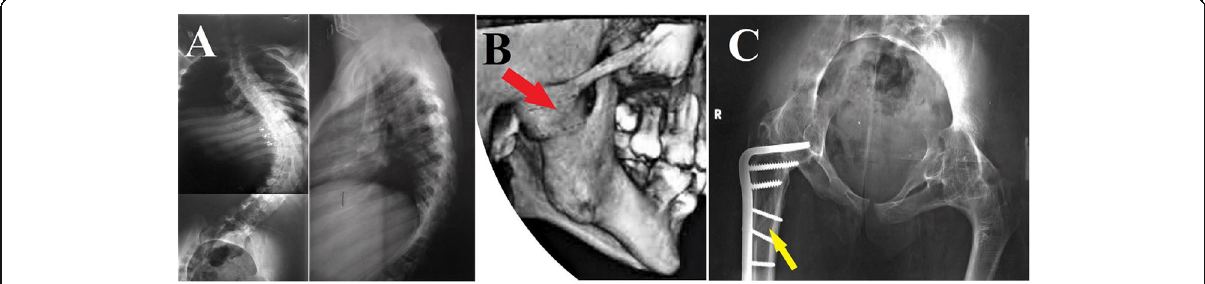
Fig. 1 Serial imaging studies performed in the emergency department. a Plan radiograph of the spine showing kyphoscoliosis deformity. b Skull CT showing fusion of the temporomandibular joint (red arrowhead). c Right femur subtrochanteric fracture fixed with a plate (fracture line indicated by the yellow